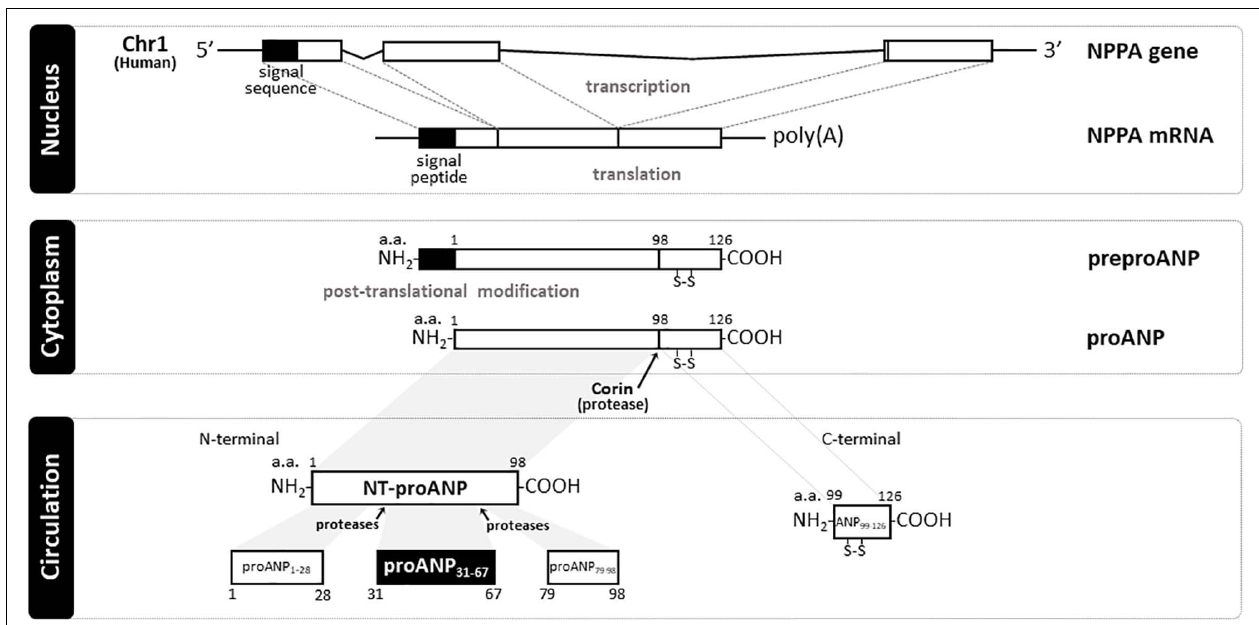
FIGURE 1 | Schematic representation of natriuretic peptide gene product processing and generated peptide fragments. In humans, atrial natriuretic peptide (ANP) is encoded by NPPA gene (Chr1:11,845,709-11,848,345:-) that translates a 151 a.a. polypeptide (preproANP). Post-translational modification process cleavages the 25 a.a. signal sequence to produce proANP, a 126 a.a. peptide that is stored in intracellular granules of atrial myocytes. Under stimulation, atrial cells release proANP that is rapidly converted to the 28-a.a. C-terminal mature ANP by the transmembrane serine protease Corin, and a 98 a.a. N-terminal mature ANP (NT-proANP or ANP 1 − 98 ). Further cleavage by proteases of NT-proANP generates different fragments, i.e., amino acids 1–28 (proANP l − 28 ), amino acids 31–67 (proANP 31 − 67 ), and amino acids 79–98 (proANP 78 − 98 ). NH2, free amine group located at the N-terminal end of a polypeptide; COOH, free carboxyl group located at the C-terminal end of a polypeptide; poly(A), multiple adenosine monophosphates mRNA tail; a.a., amino acid; Chr 1, Chromosome 1; NPPA, human atrial natriuretic peptide gene; ANP, Atrial natriuretic peptide; NT-proANP, N-terminal proatrial natriuretic peptide; preproANP, precursors to prohormone of atrial natriuretic peptide; proANP, prohormone of atrial natriuretic